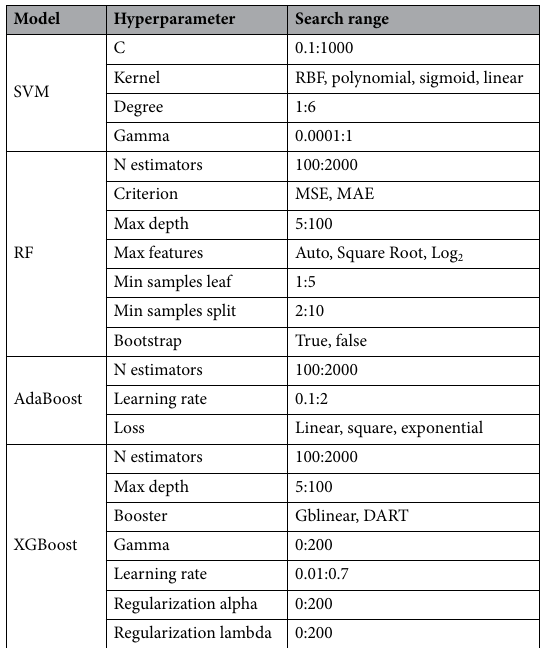
Table 2. Initial hyperparameter search space ( SVM support vector machine, RF random forest, RBF radial basis function, MSE mean squared error, DART dropouts meet multiple additive regression